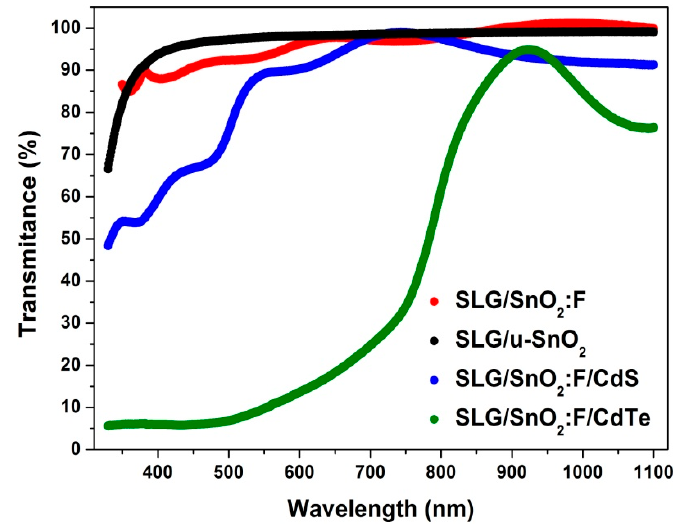
Figure 1. Transmission spectra for the different layers studied in this paper.